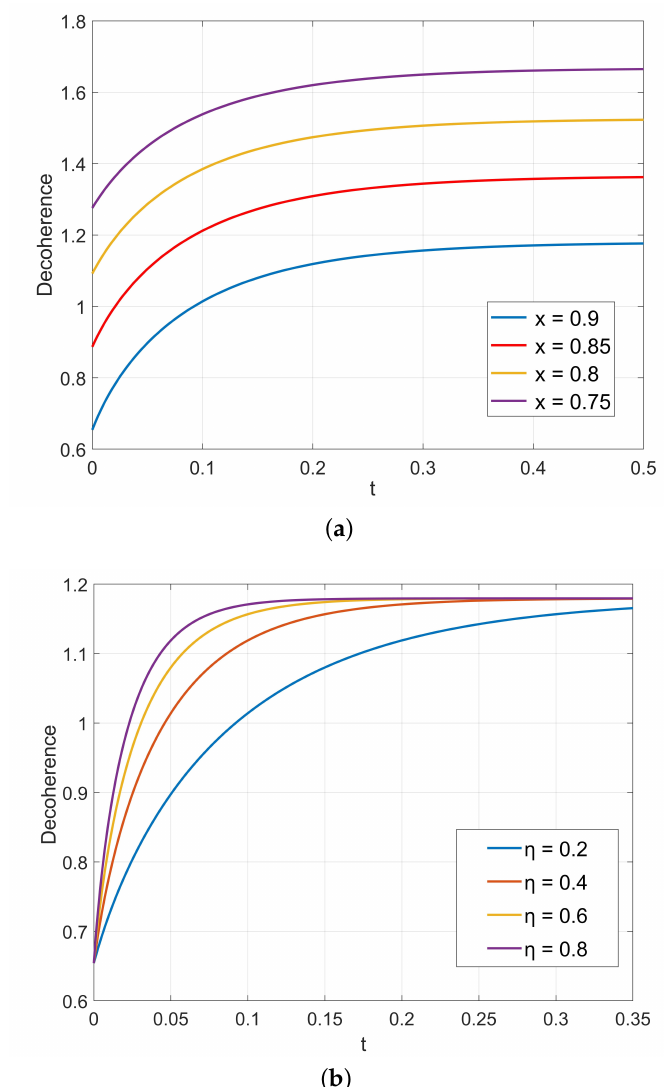
Figure 4. Decoherence as measured by von-Neumann entropy for damping factor linear in time (in seconds) ( a ) for different mixing parameters at a fixed interaction strength η = 0.2, ( b ) for different interaction strengths at a fixed mixing parameter x = 0.9. It is observed that for different mixing parameters, the entropy saturates after some time, and the rate at which it is achieved increases with the increase in η